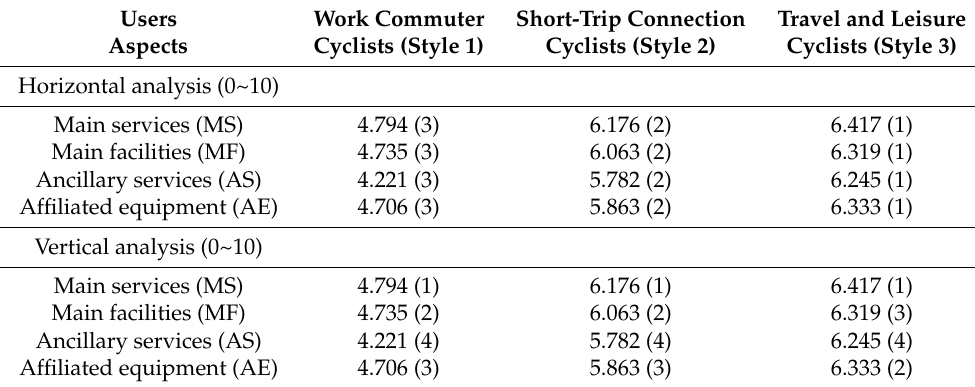
Table 14. The competitive analysis of PBSSSs for three styles of